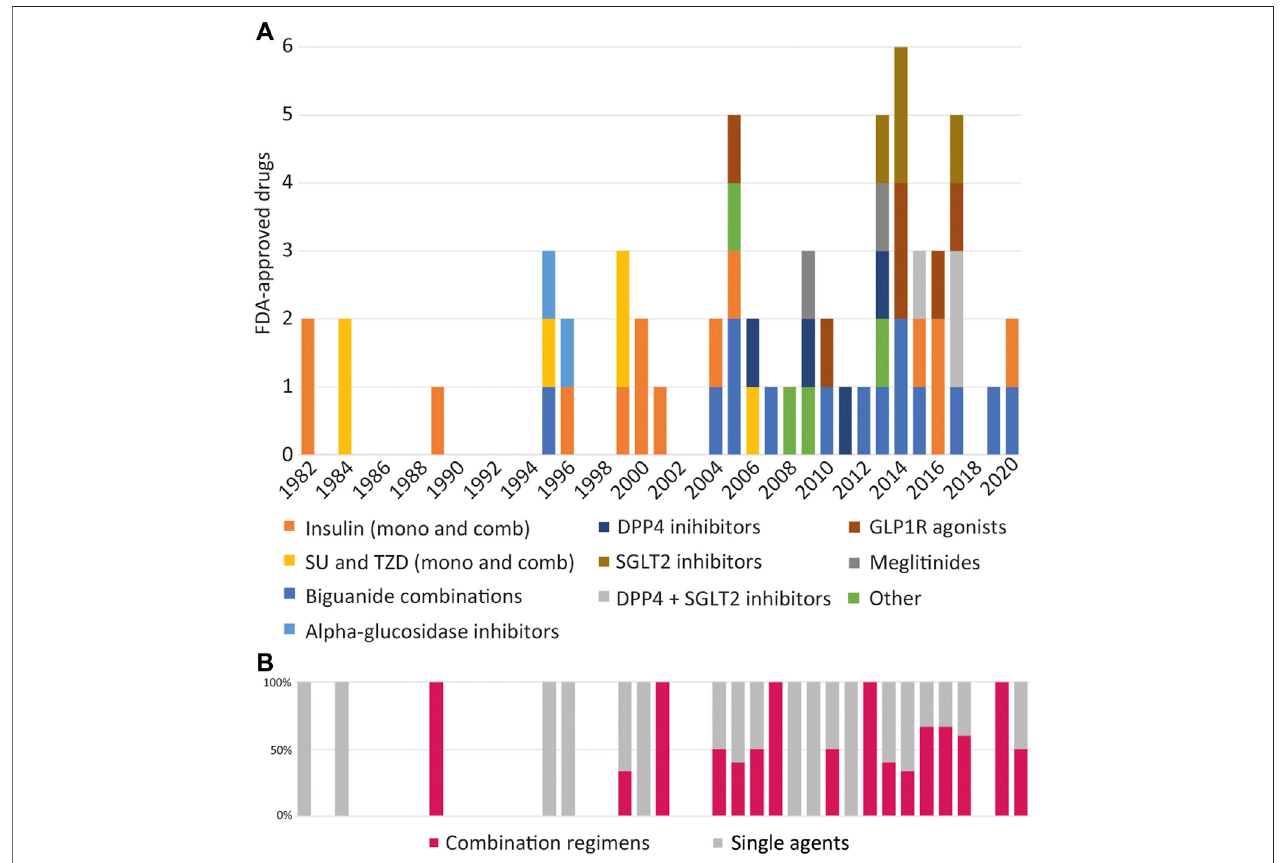
FIGURE 3 | FDA-approved drug classes per year. (A) Timeline of the major classes ofantihypertensive drugs that have approved including monotherapies (mono) and combinations (comb). DPP4, Dipeptidyl peptidase 4; GLP-1R, Glucagon-like peptide-1 (GLP-1) receptor; SGLT2, Sodium-glucose co-transporter-2; SU, Sulfonylureas; TZD, Thiazolinediones. (B) The proportion of combination regimens in comparison to monotherapies that have been approved each year. The use of agents in two and three combination regimens is increasing as treatment options expand to target multiple facets of diabetes pathophysiology.